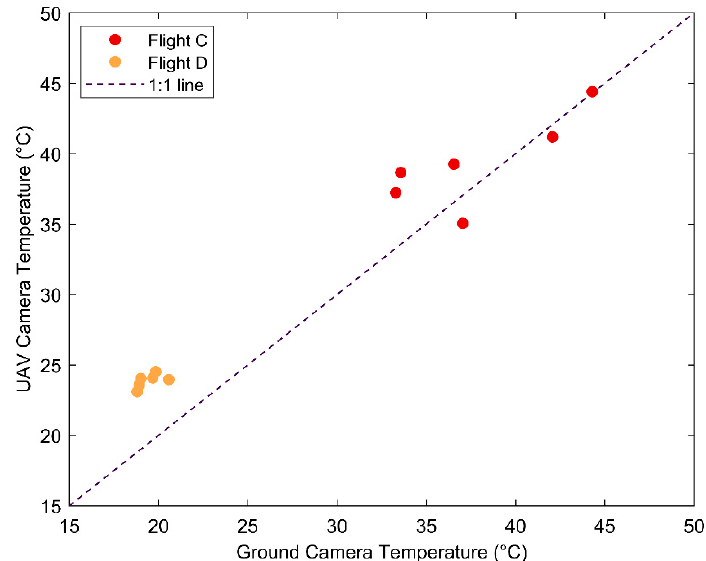
Figure 9. Validation of vegetation temperature recorded by the UAV camera with vegetation temperature recorded by the ‘ground camera’ for six ROIs during Flights C and D.